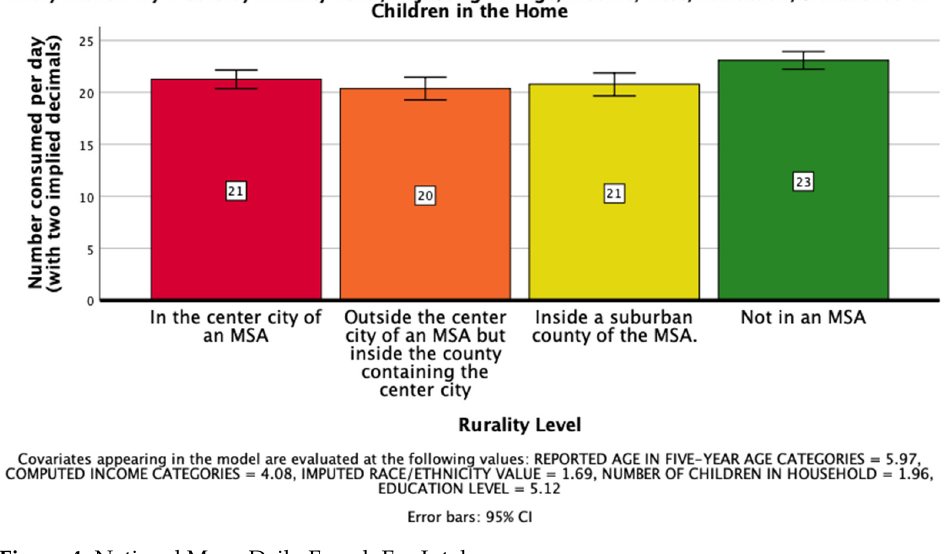
Figure 4. National Mean Daily French Fry Intake.